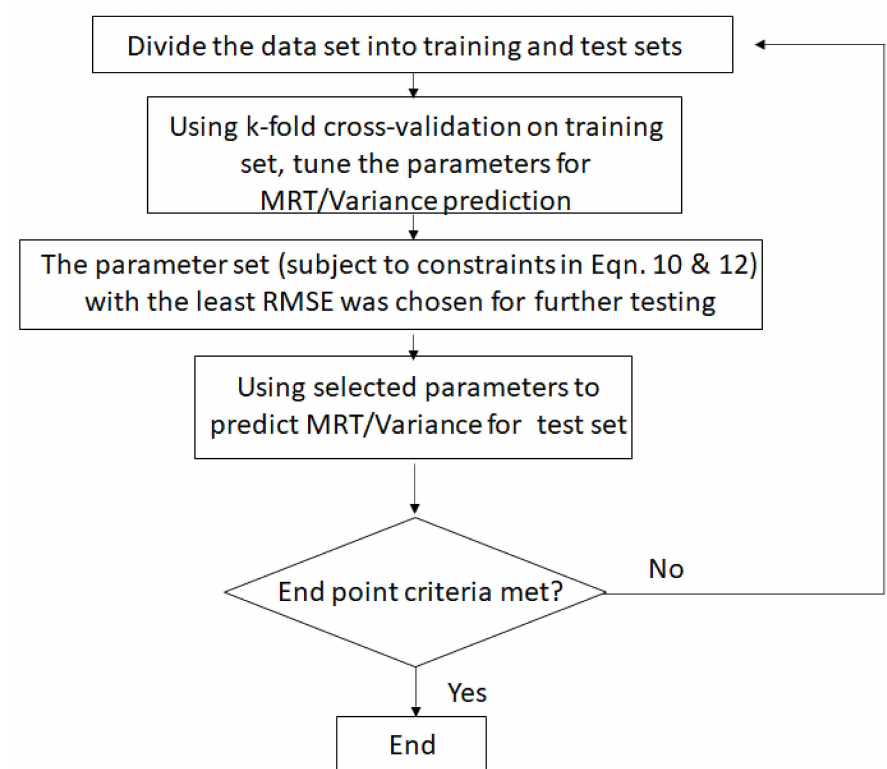
Figure 3. Schematic for algorithm adopted to train and validate mean residence time (MRT) and variance models on